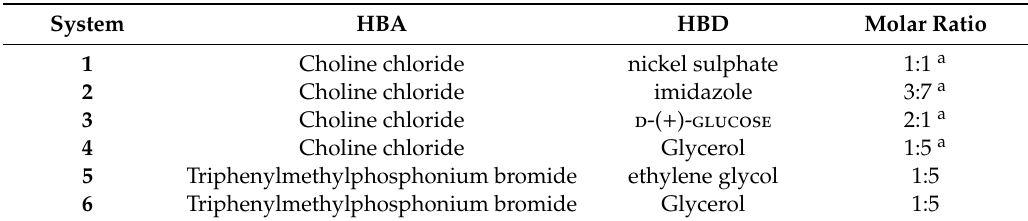
Table 1. Composition and nomenclature of presented systems. Note: HBA, hydrogen bond acceptor; HBD, hydrogen bond